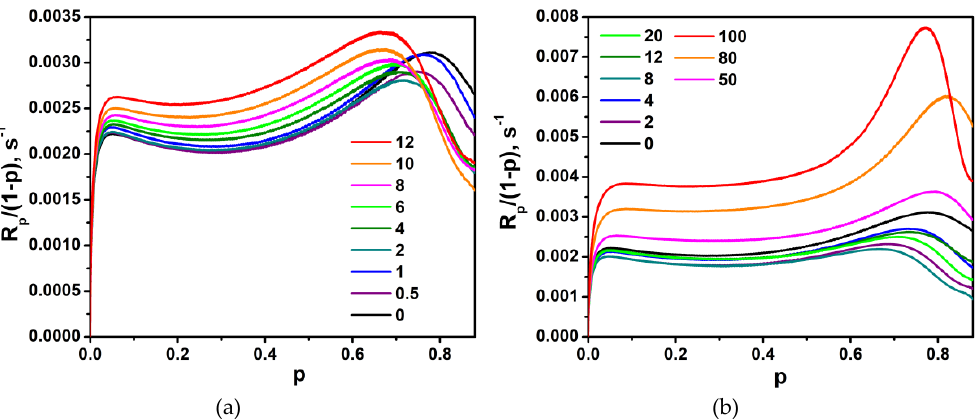
Figure 8. R p /(1-p) as a function of the double bond conversion, p , at 40 °C for ( a ) LM/1M-POSS and ( b ) LM/TSM systems. The numbers indicate the modifier content (mol %) in the composition.